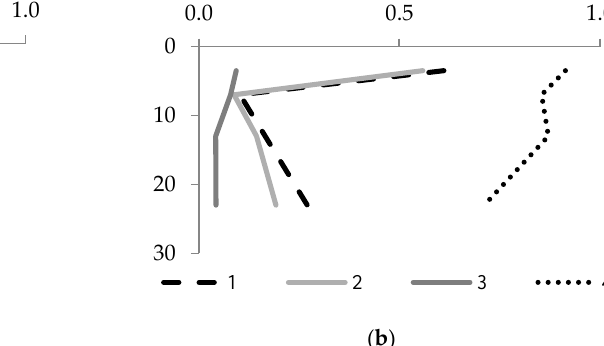
Figure 5. The profile distribution of total content of Si, Al and Fe in the background and quarry soils. All abbreviations are explained at Table 1.